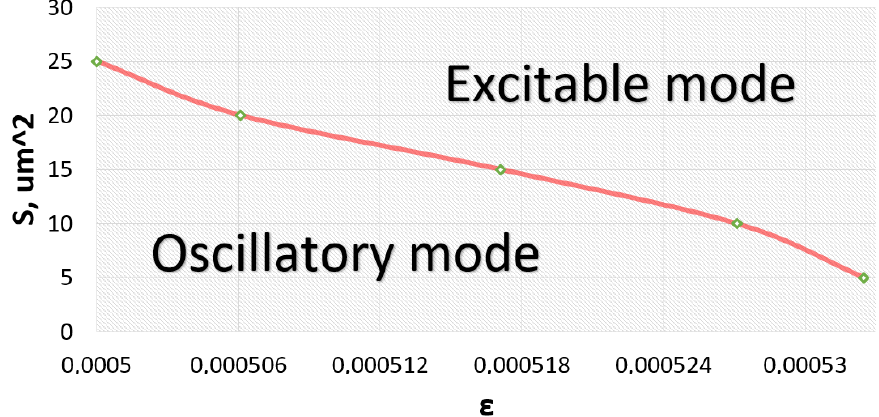
Figure 11. Two–parameter bifurcation Figure 11. Two − parameter bifurcation diagram.